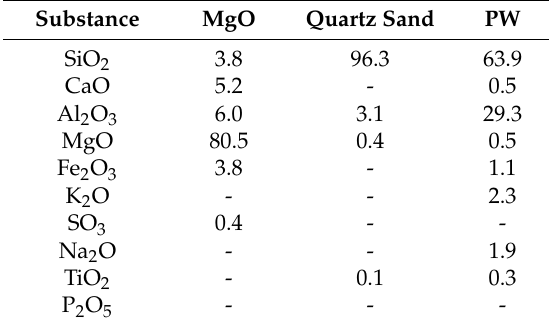
Table 2. Chemical composition of caustic MgO, quartz sand, and PW (wt. %).